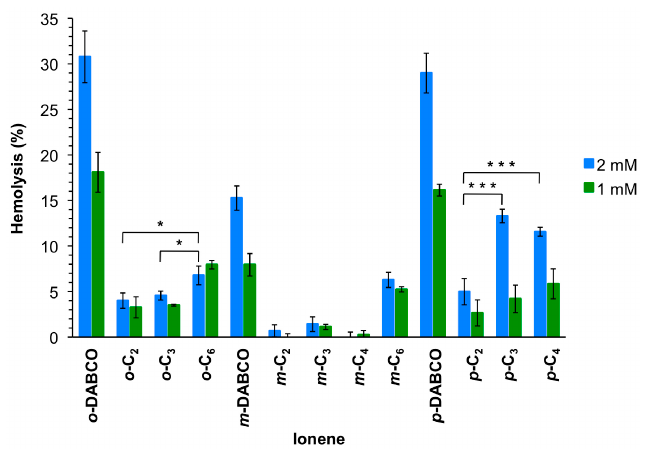
Figure 3. Mean values of hemolysis from at least three replicates with SD and ANOVA with Bonferroni comparison. For the sake of clarity, only comparisons within one topomeric set ( ortho -, meta -, para -) at 2 mmol/L are shown in this plot. All DABCO-containing compounds showed higher hemolysis (***, omitted for clarity) in comparison to their set members. * Indicates p < 0.05; *** indicates p < 0.001. See Supplementary Material for additional comparisons (Figures S19,S20).